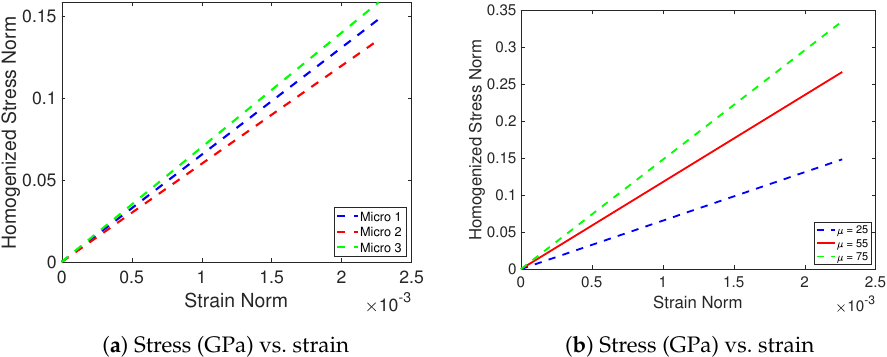
Figure 5. ( a ) Comparison of homogenized behavior (Linear) of 3 microstructures under mono- tonic loading, the geometrical features for these 3 microstructures are [0.358, 0.455, 0.278, 0.178], [0.313, 0.465, 0.36, 0.226], [0.478, 0.28, 0.143, 0.064] (1-point, 2-point, 3-point, and Linear-path proba- bilistic functions, respectively), ( b ) comparison of homogenized behaviour (Linear) of 1 microstruc- ture with different material properties ([0.358, 0.455, 0.278, 0.178] are 1-point, 2-point, 3-point, and linear-path probabilistic functions, respectively) under monotonic